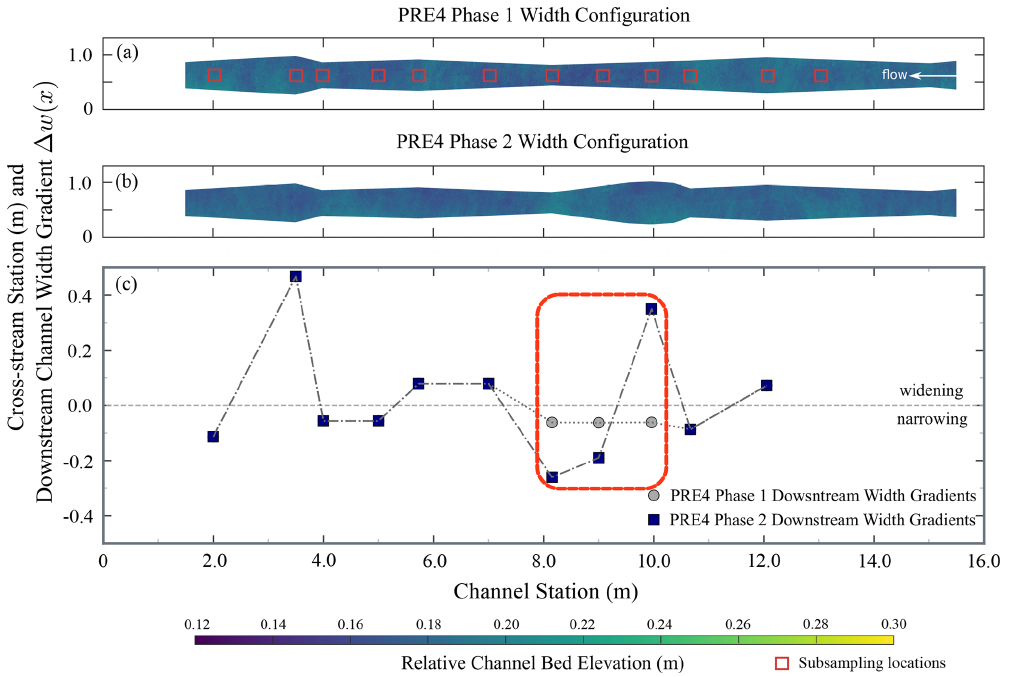
Figure 2. Experimental design of channel width gradients for Phases 1 and 2 of PRE4. (a) Overhead view of the Phase 1 experimental channel showing how channel width changes in the downstream direction. Phase 1 ended at elapsed time 960min (see Table 1). (b) Overhead view of the Phase 2 experimental channel showing how channel width changes in the downstream direction. Phase 2 began following Phase 1. Color shading for both (a) and (b) represents a relatively smoothed elevation condition for illustration only. The Phase 2 width configuration corresponds to the setup reported by Chartrand et al. (2018). (c) Downstream channel width gradients for Phases 1 and 2, connected by lines for illustration only. Points are plotted at locations that correspond to the red squares of (a) , which set the downstream differencing length scale and locations where mean local width was calculated. Values above the zero-width gradient line represent widening conditions, and those below this line represent narrowing. The dashed red polygon highlights the location from approximately station 10.6 to 8.15m where the bank positions were manipulated at elapsed time 960min as per the experimental